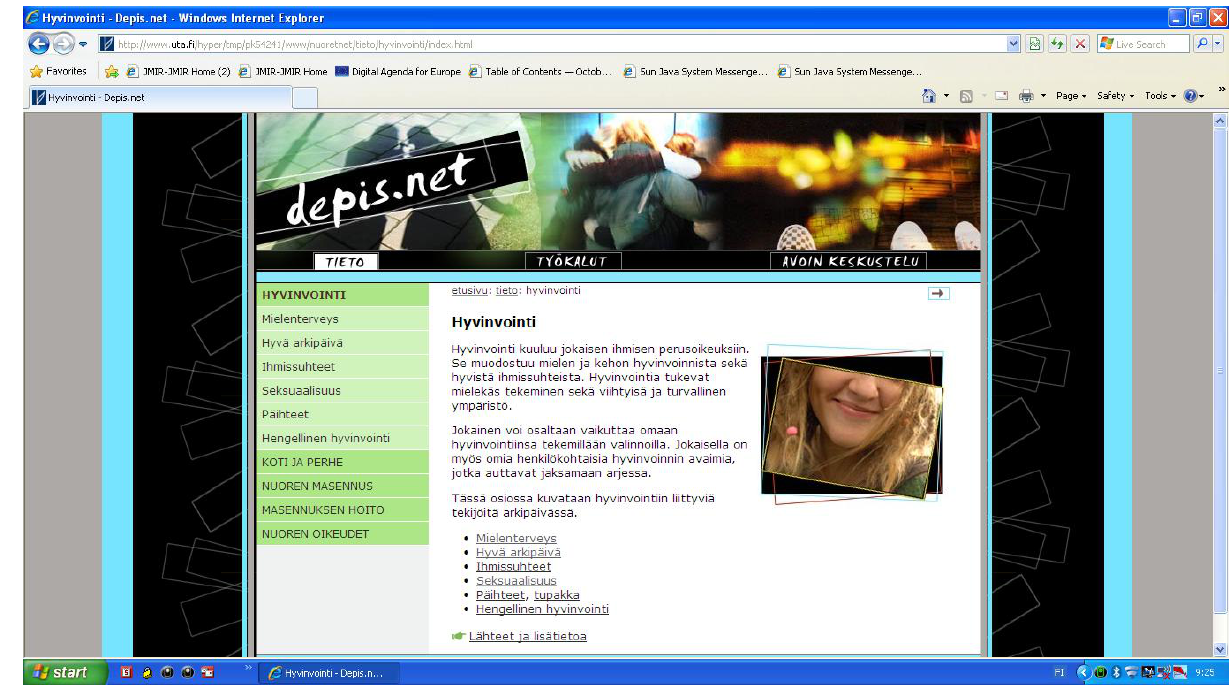
Figure 2. Different themes of the intervention on the Depis.Net